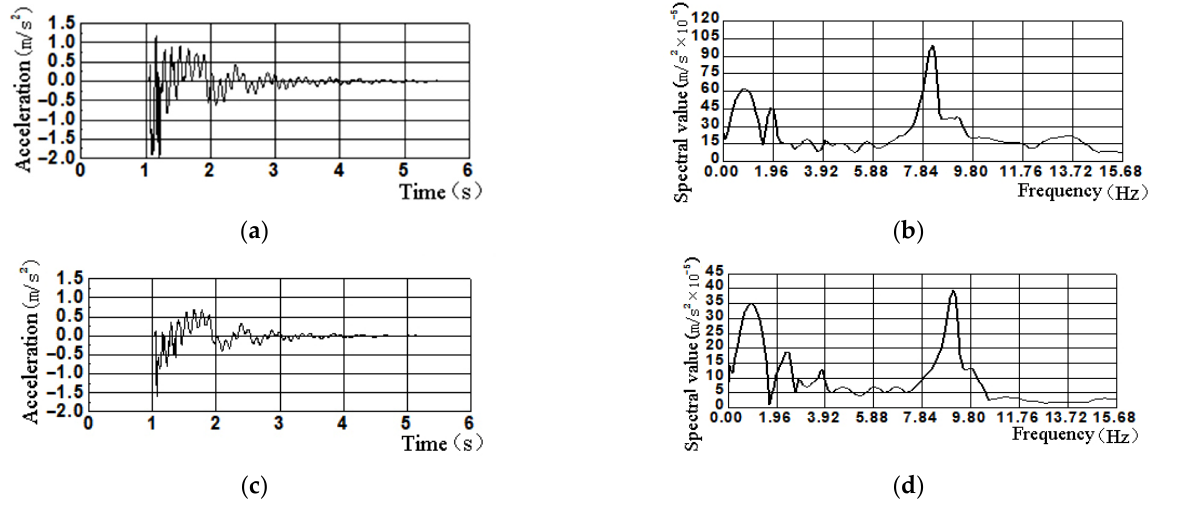
Figure 20. Acceleration attenuation curve and the related spectrum: ( a ) acceleration attenuation curve (roof floor); ( b ) spectrum (roof floor); ( c ) acceleration attenuation curve (first floor); ( d ) spectrum (first floor). Table 5. Structural acceleration and seismic-reduction rate.